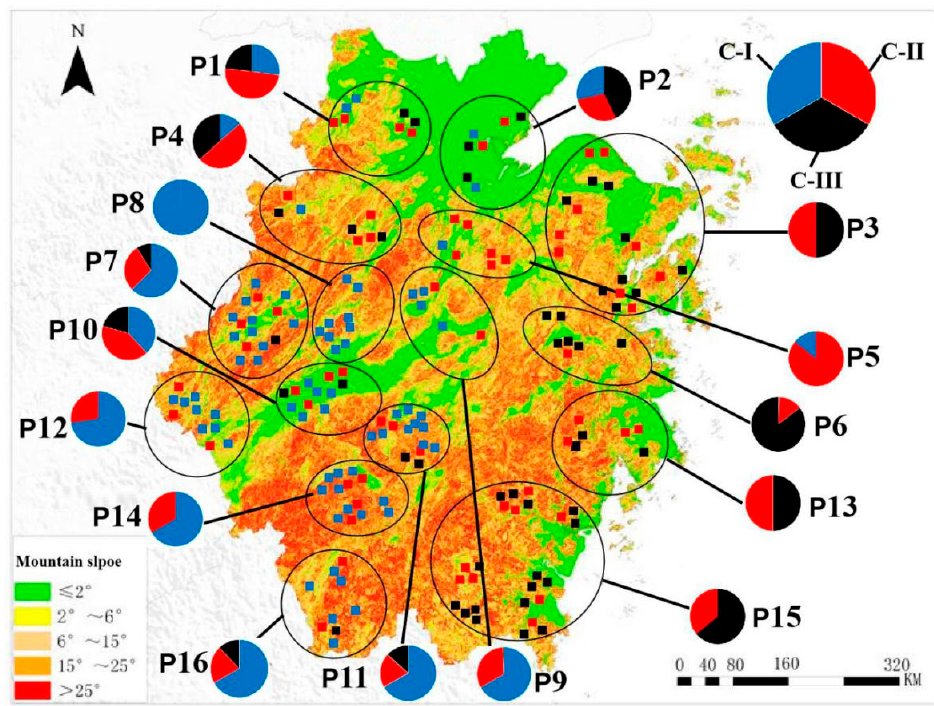
Figure 8. Distribution and quantity of 179 D. kaki samples from different regions in Zhejiang Province. Each circle represents different ecologic regions of sampled D. kaki germplasms. P1–P16 represents the 16 populations of germplasms. The pie chart with different color parts represents the different clusters, and the blue parts represent Cluster-I (C-I), the red parts represent Cluster-II (C-II), and the black parts represent Cluster-III (C-III). Every dot represents every germplasm, the blue dot represent the germplasm of Cluster-I, the red dots represent the germplasm of Cluster-II, and the black dots represent the germplasm of Cluster-III. Table 6. Comparison of genetic diversity parameters for the germplasm clusters.